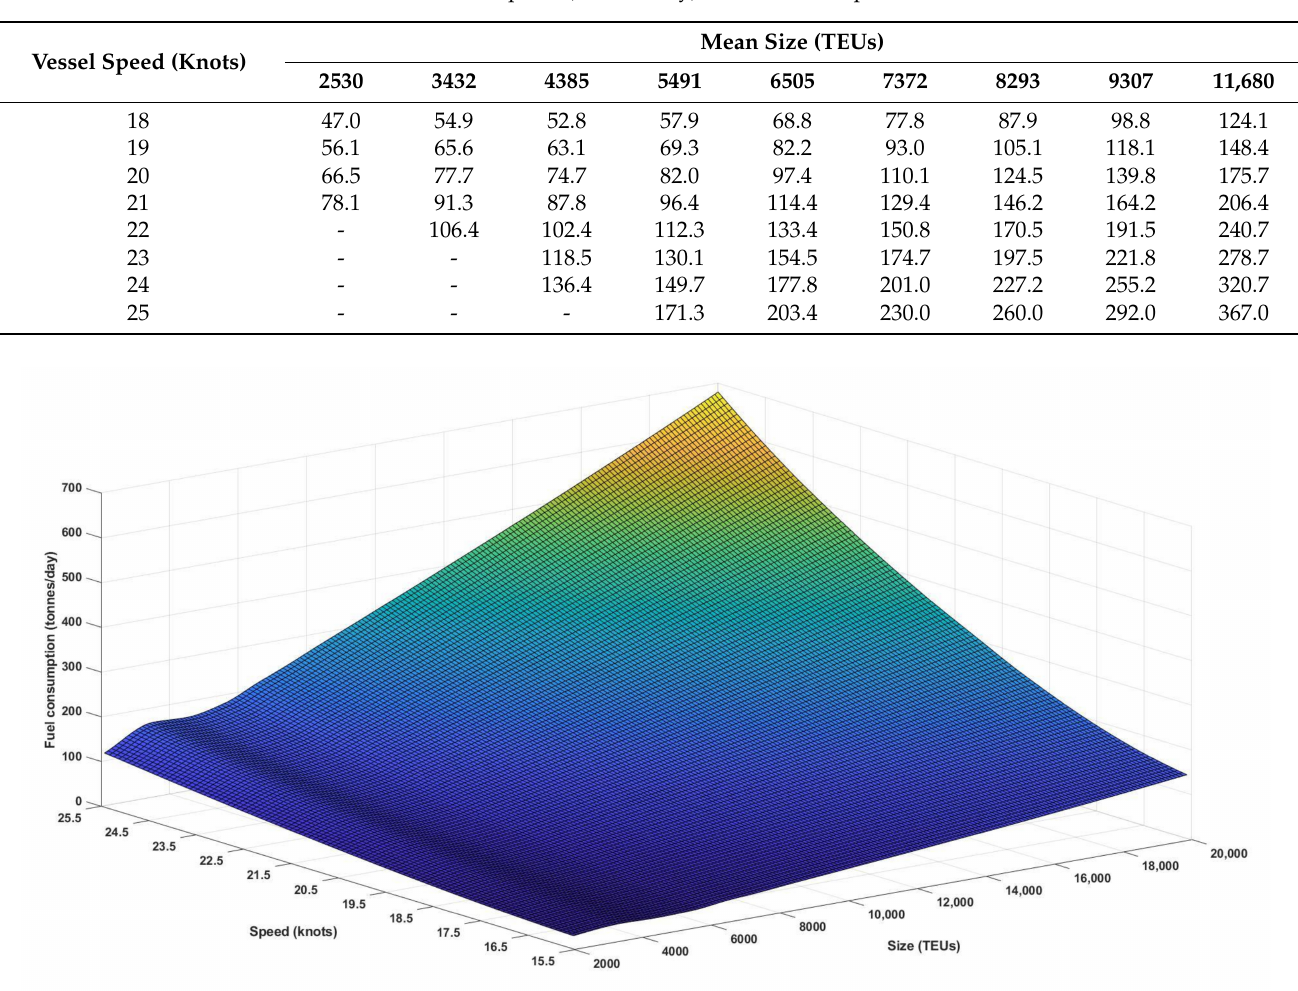
Table 4. Fuel consumption (tonnes/day) as function of speed and size.